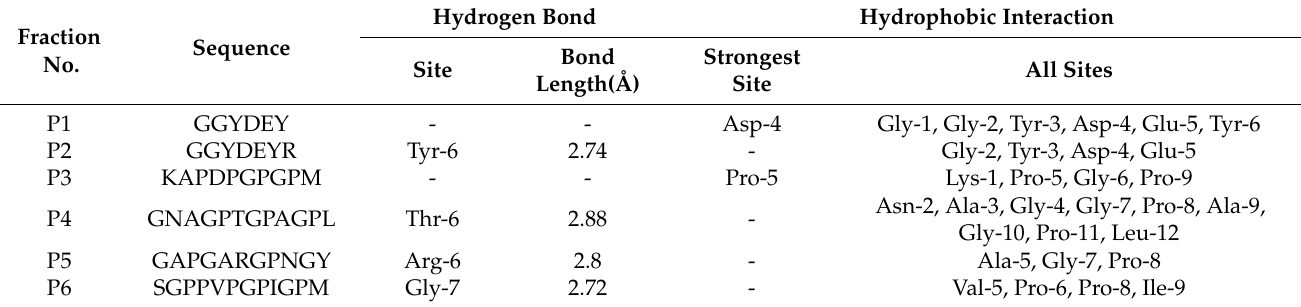
Figure 3. Molecular docking model 2D display to identify the interaction of synthetic antioxidant peptides with DPPH. ( a ) P1; ( b ) P2; ( c ) P3; ( d ) P4; ( e ) P5; ( f ) P6. Amino acid residues surrounding the active peptides involved in the interaction are marked with different colours (green for hydrogen bonds and red for hydrophobic interactions) for ease of observation. Interactions between peptides and DPPH are marked with dashed lines in different colours (purple for regular hydrogen bonds and red for strong hydrophobic bonds). Table 3. Summary of molecular docking results between peptides identified from tilapia skin and DPPH free